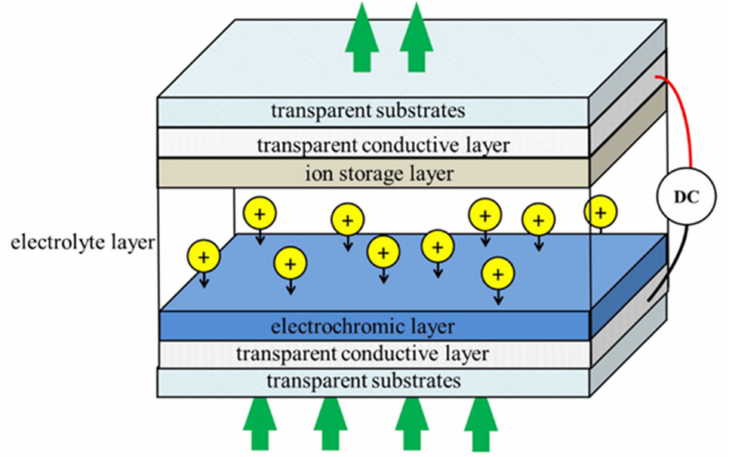
Figure 3. A typical ECD design. Arrows indicate the movement of ions and electrons in an applied electric field